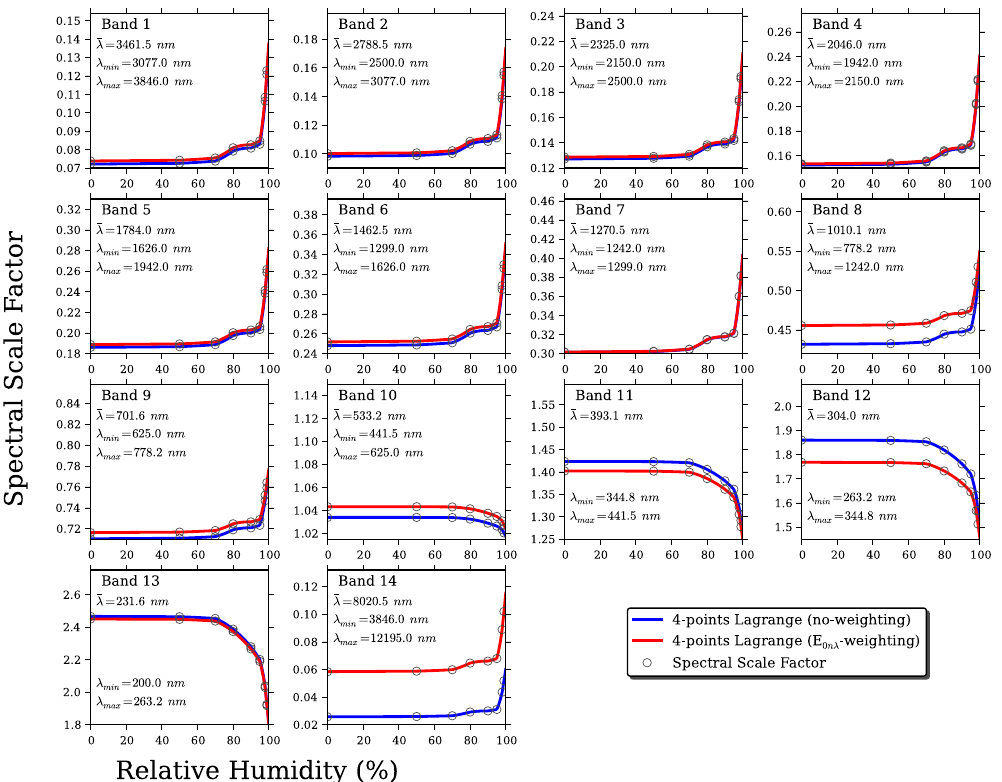
Figure 1. AOD spectral scale factor interpolated using 4-point Lagrange interpolation for relative humidity values from 0 to 99% for each RRTMG spectral band and the rural aerosol model. For the sake of comparison, the results using E on -weighted and unweighted spectral scale factors are